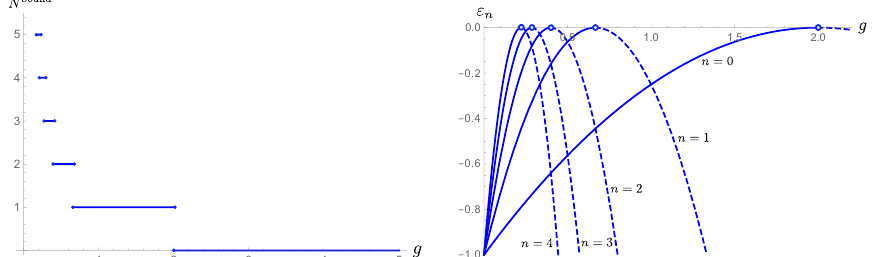
Figure 3. ( Left ) The number of the allowed bound states in the Morse potential. ( Right ) The exact spectrum ε n against the parameter g . The solid lines are the physical bound state energies while the dashed lines are on the unphysical branch. For 2/3 < g < 2, the branch for n = 0 is physical but those for n ≥ 1 are all unphysical. The total number of the bound states is N bound = 1, which is consistent with the left